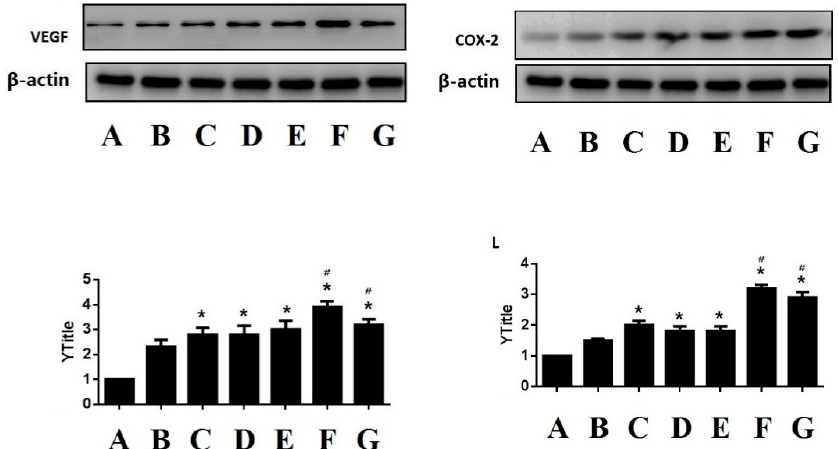
Figure 5. Western blot result showed the effect of compound LSZ capsule on the expression of VEGF and COX-2 ( n = 6). ( A ) Intact; ( B ) Model; ( C ) reference product of 30-mg enteric-coated capsules of LSZ (2.7 mg/kg); ( D ) LSZ (2.7 mg/kg); ( E – G ) test product of 30-mg capsules of compound LSZ (LSZ:NaHCO 3 ): (1.35 mg/49 mg), (2.7 mg/99 mg) and (5.4 mg/198 mg) for compound LSZ-L, compound LSZ-M and compound LSZ-H groups, respectively.* p < 0.05 compared with intact group.